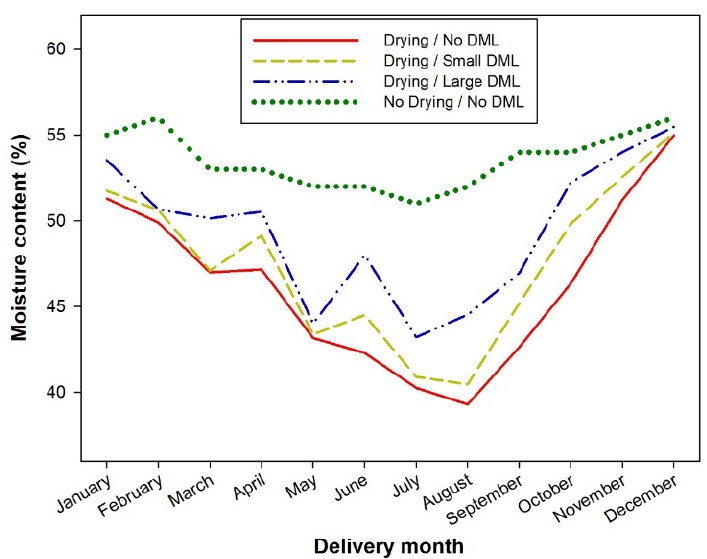
Figure 4. MC variation for roundwood and residues for the four scenarios.